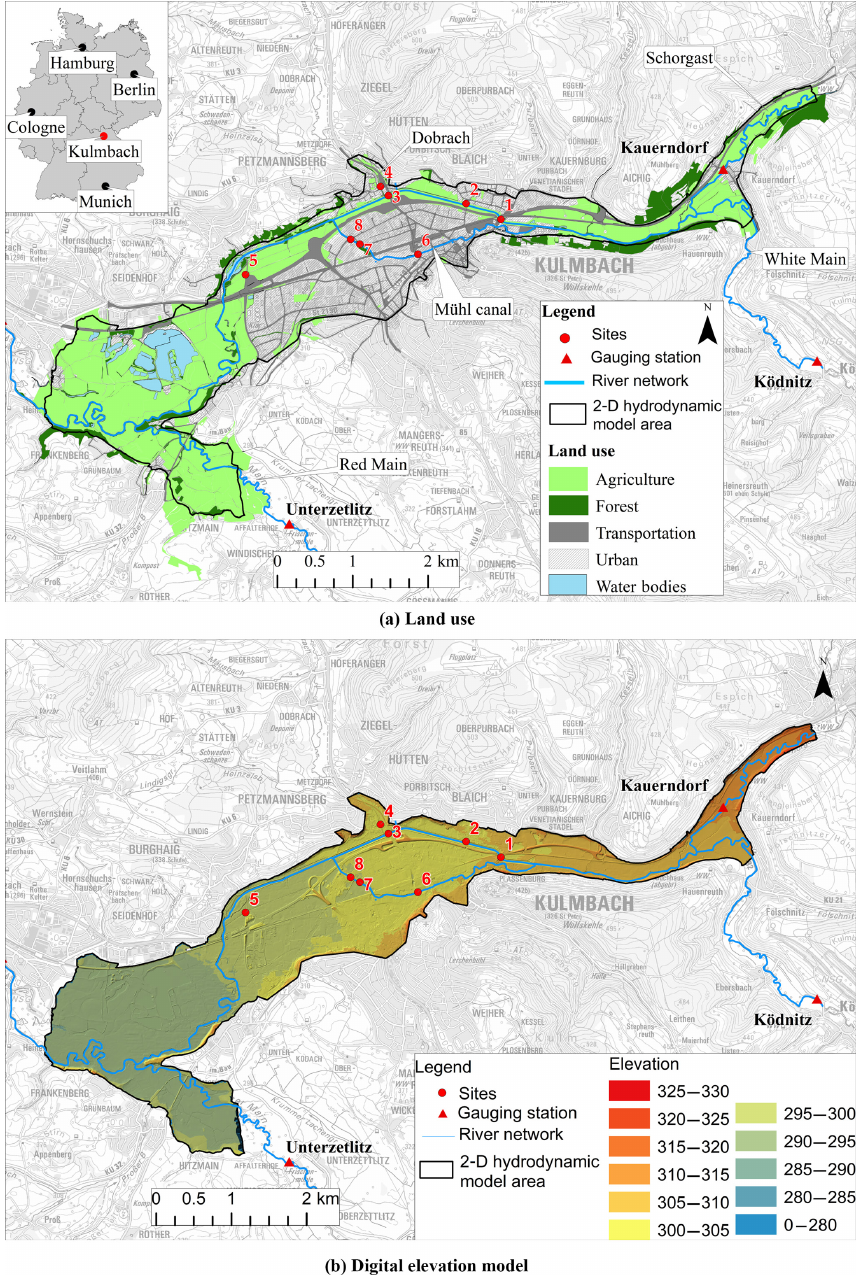
Figure 1. Land use and the digital elevation model of the city of Kulmbach. Data source: Hof water management